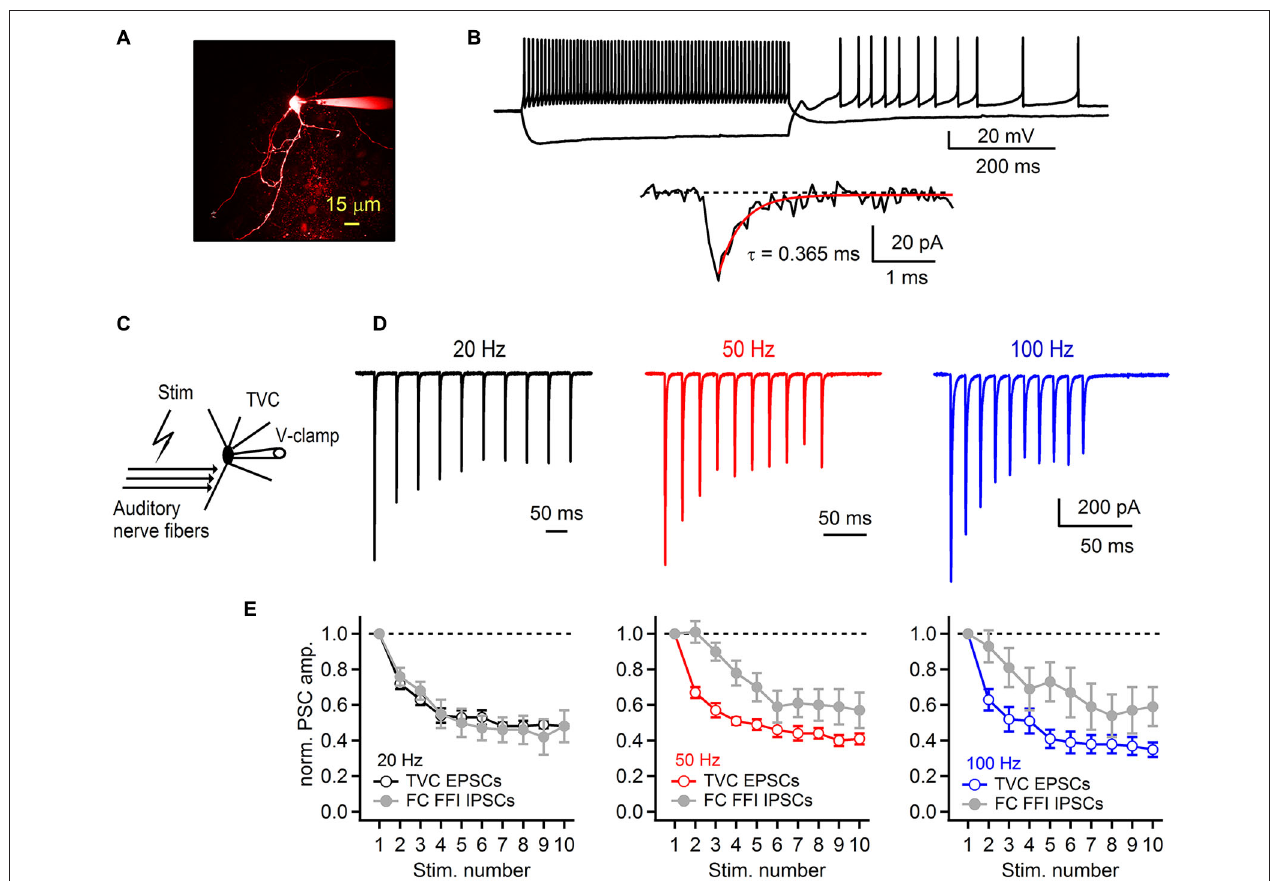
EPSCs recorded from a tuberculoventral cell during repetitive auditory nerve stimulation at 20, 50 and 100 Hz. All recordings were performed with 2 µ M strychnine and 40 µ M picrotoxin in the perfusion solution. Note the pronounced depression that is comparable to the amount of depression of the inhibitory component of FFI sequence recorded from FCs. Stimulation artifacts were removed for clarity. Traces represent averages of 5–10 trials. (E) Plots of EPSC amplitudes at corresponding stimulation frequencies of the auditory nerve. Gray data of IPSC short-term plasticity recorded from FCs during feed-forward inhibition trials and shown in Figure 4 are included for comparison. EPSCs in the train were normalized to the first EPSC in the train ( n = 6